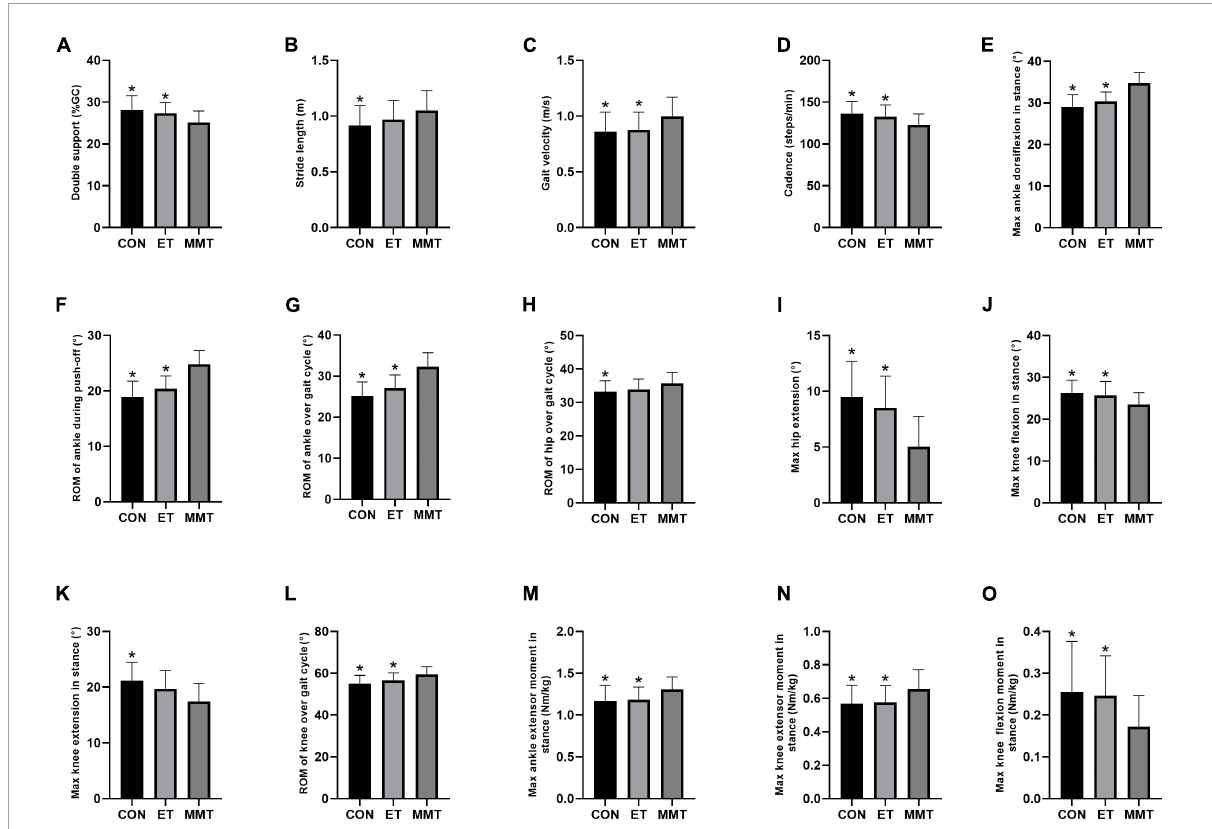
FIGURE2 Gait parameters. Gait parameters were expressed in mean ± standard deviation. One-way ANOVA was used to compare the difference between CON, MMT, and ET. Significance level was set at 0.05. * p < 0.05, compared with the MMT group. ROM, range of motion; MMT, music-based movement therapy; ET, exercise therapy; CON, control. (A) Gait cycle, (B–D) kinematic parameters, (E–L) joint angle parameters and (M–O) kinetic